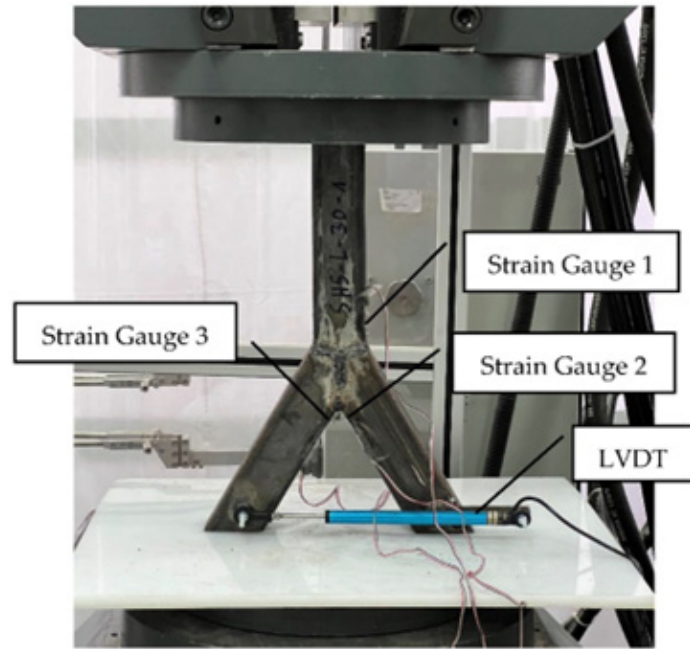
Figure 2. Testing setup.